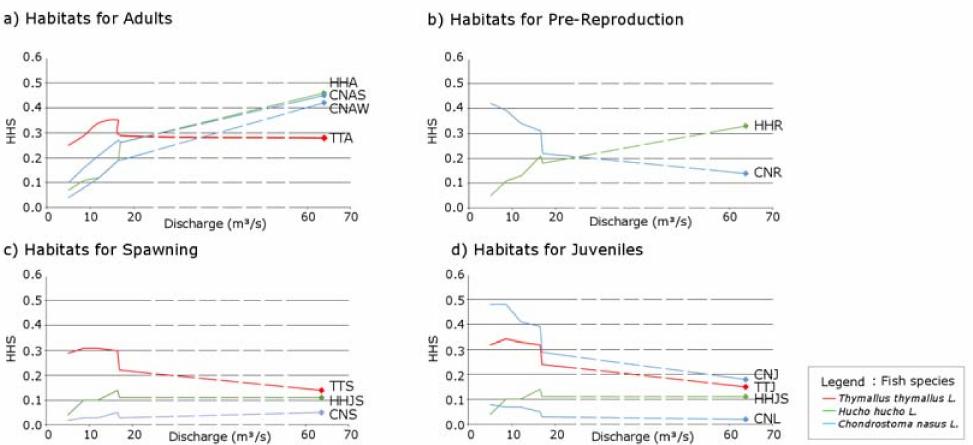
Figure 4. Hydraulic habitat suitability (HHS) for the twelve habitat types considering discharge variations from 5 to 68.5 m 3 /s: ( a ) Habitat for Adults C. nasus in winter (CNAW), C. nasus in summer (CNAS), T. thymallus (TTA), and H. hucho (HHA); ( b ) Habitat types for Adults pre-reproduction H. hucho (HHR) and C. nasus (CNR); ( c ) Habitat type for Adults spawning T. thymallus (TTS), H. hucho (HHJS), and C. nasus (CNS); ( d ) Habitat types for Juveniles C. nasus (CNJ), T. thymallus (TTJ), and H. hucho (HHJS), and for larval development of C. nasus